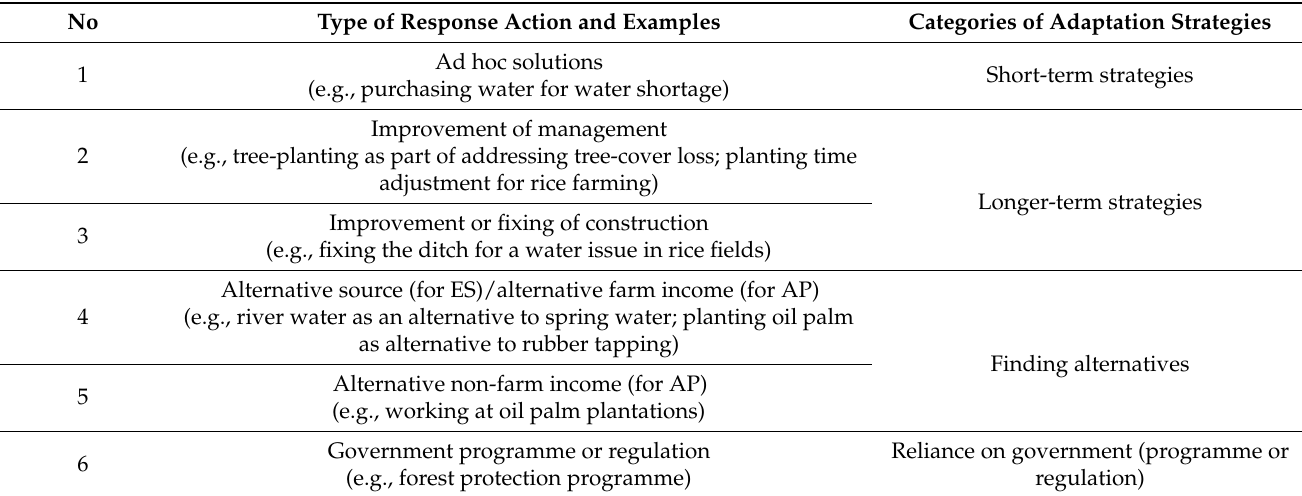
Table 2. Types of response actions and